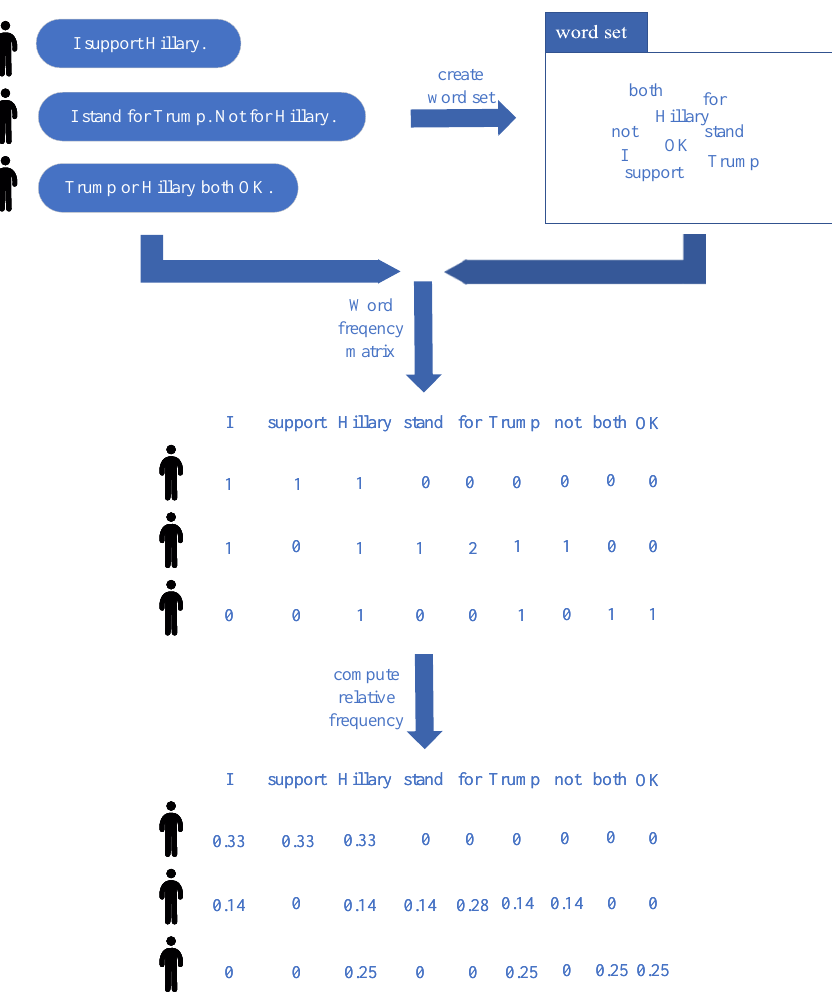
Figure A1. An illustration for the generation of U for pure-autoencoder based on an simple